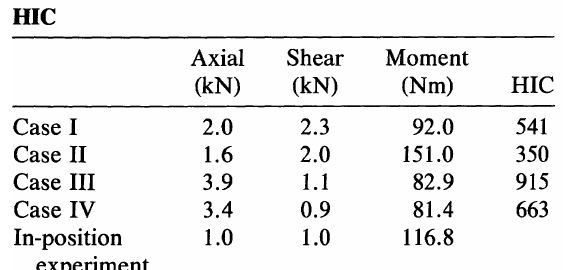
Table 2. Calculated Maximum Neck Forces and